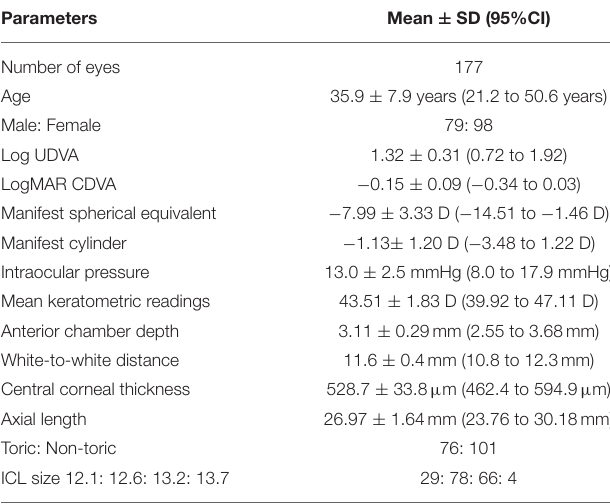
TABLE 1 | Preoperative patient demographics of the study